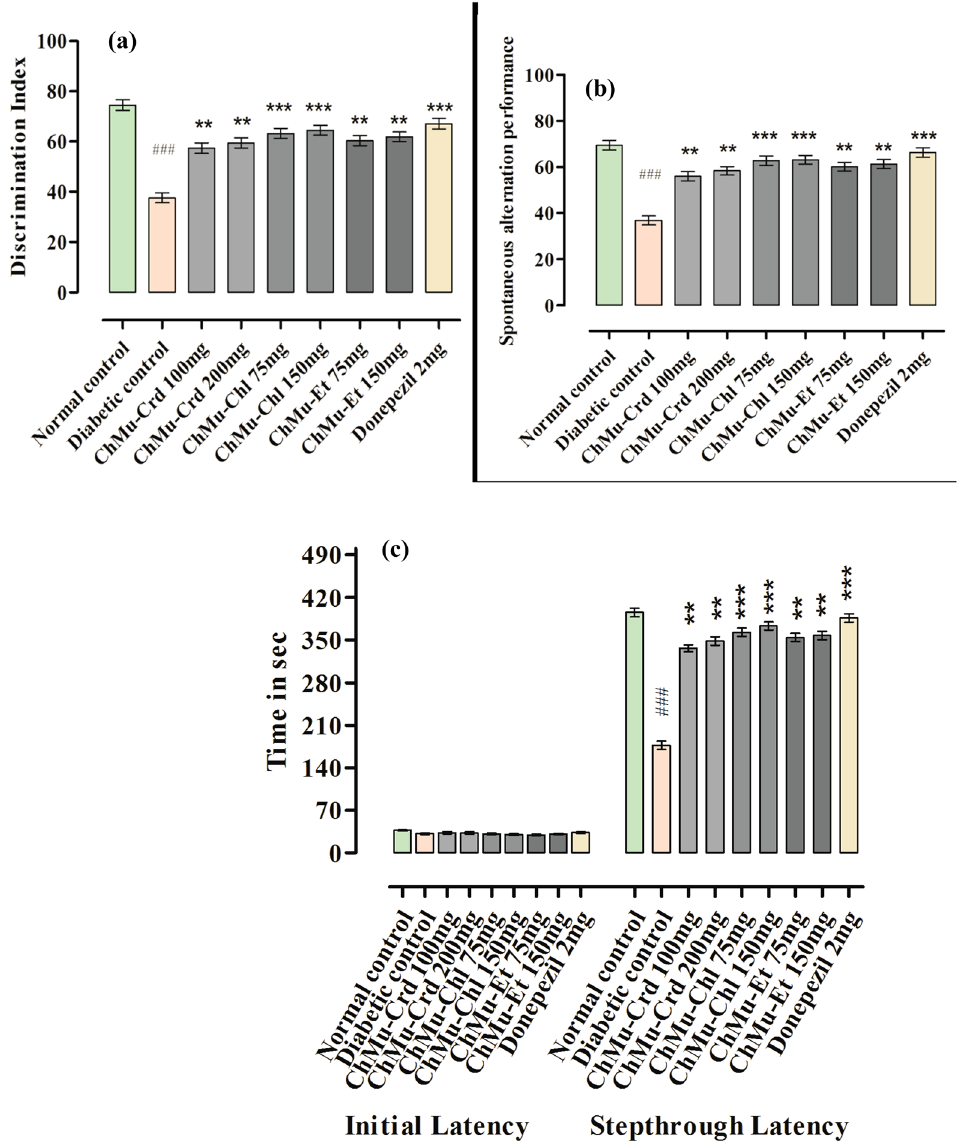
Figure 1: Behavioral results from crude extract and its fractions of C. murale . ( a ) Percent DI in the NODT, ( b ) % spontaneous alternation performance in Y - maze test, and ( c ) PAT for assessment of initial and step - through latencies. Mean ± SEM ( n = 6 ) . One - way ANOVA followed by Dunnett ’ s post hoc multiple comparison tests to ascertain the P - values. ### P < 0.001 comparison of STZ - treated diabetic ( amnesic ) group vs normal control, * P < 0.05, ** P < 0.01, and *** P < 0.001 as comparison of STZ - treated diabetic ( amnesic ) group vs donepezil, crude extract, and fraction - treated groups, using one - way ANOVA followed by Dunnet comparison. Crude extract, chloroform, and ethyl acetate